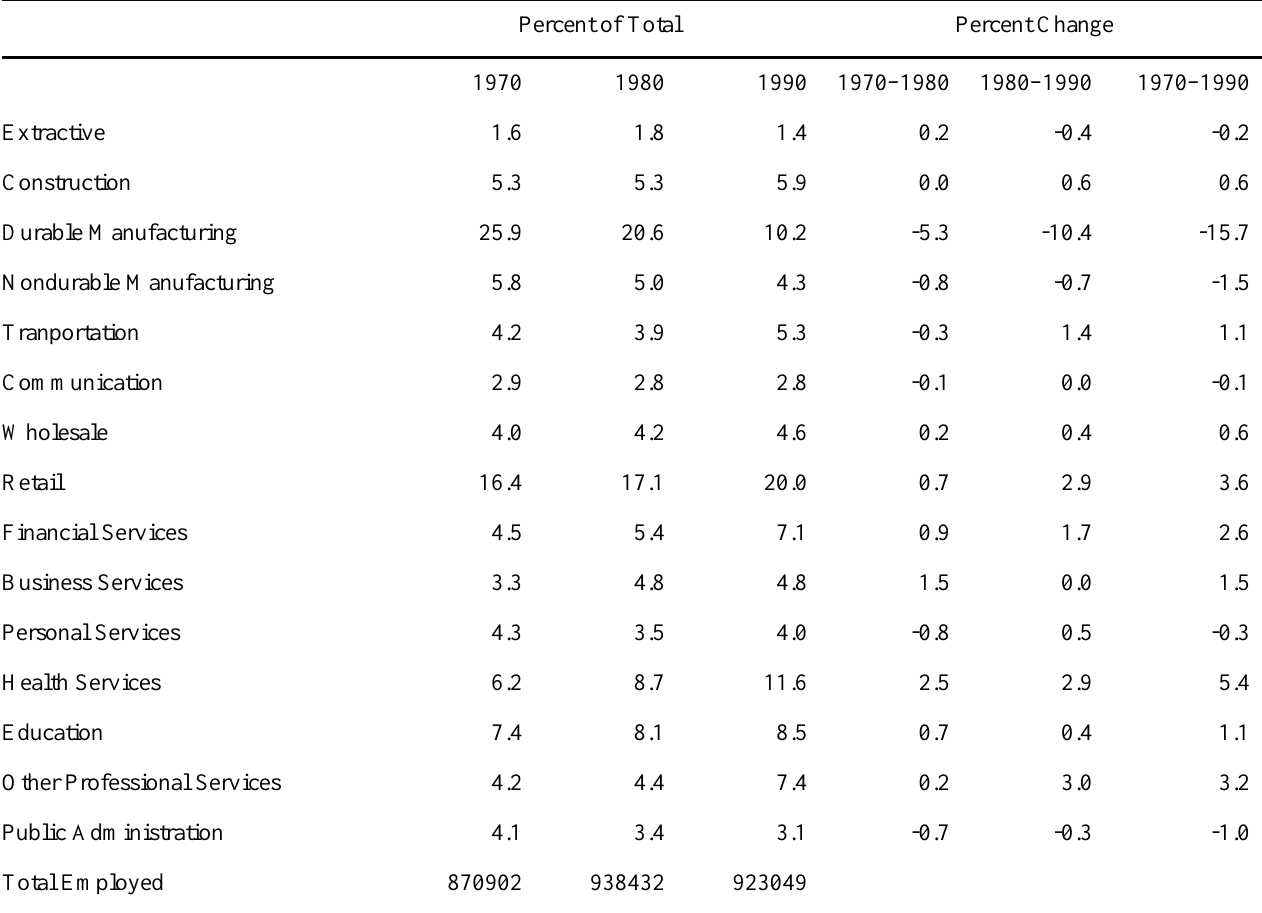
Table 3. Employment by industry in 1970, 1980, and 1990, Pittsburgh Standard Metropolitan Statistical